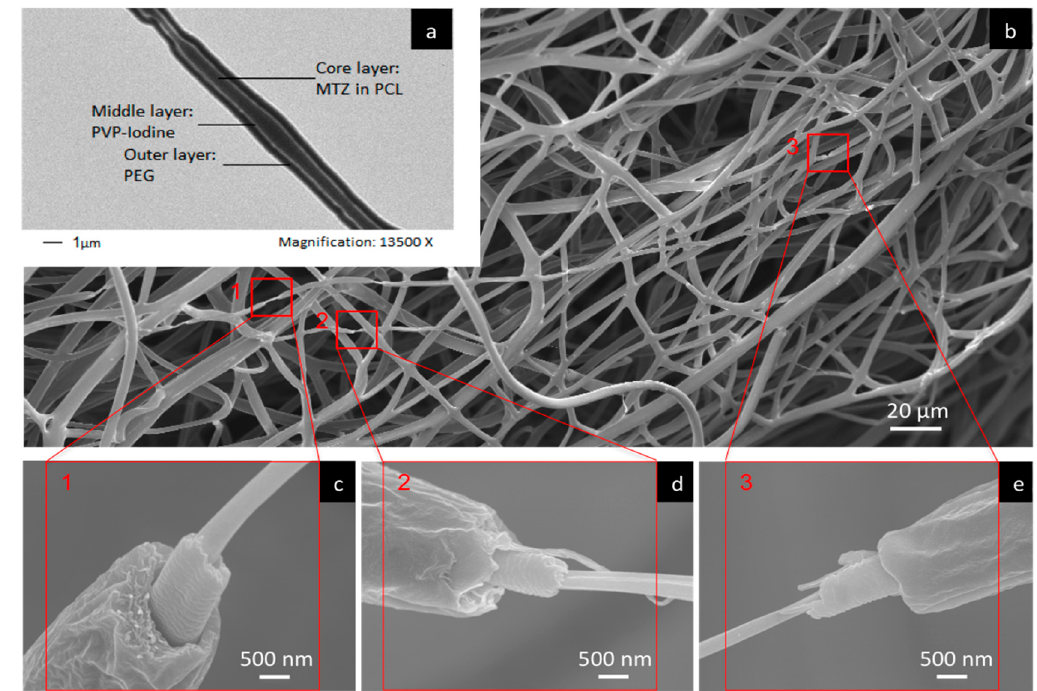
Figure 3. ( a ) TEM and ( b – e ) SEM images showing the three-layer compartmental structure of trilayered fibers, generated with 10 wt % PVP-I/PVP (1:1 w/w) in the middle